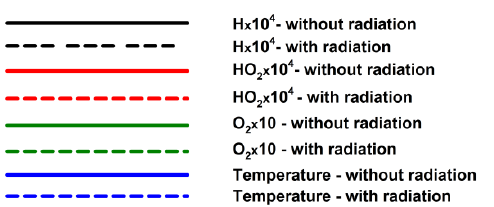
Figure 7. Axial distribution of static temperature, selected species mass fractions ( a – c ) and reaction rates for R9 and R11 ( d – f ) along the axis for ( a , d ) quartz, v = 0.13 m/s, ( b , e ) steel, v = 0.14 m/s and ( c , f ) aluminum, v = 0.14 m/s.